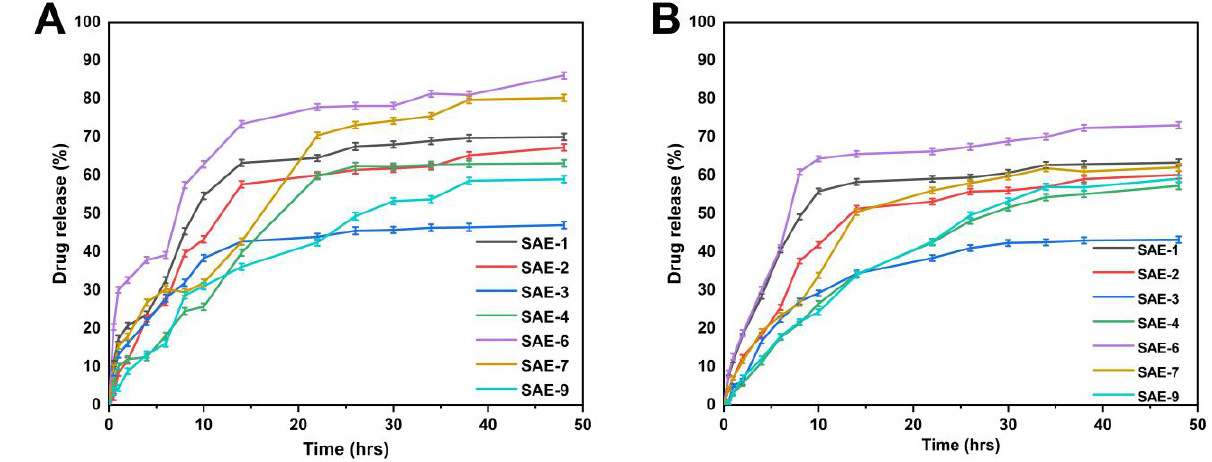
Figure 9. In vitro drug release of SA-g-AMPS hydrogels at pH 1.2 ( A ) and 7.4 ( B ).